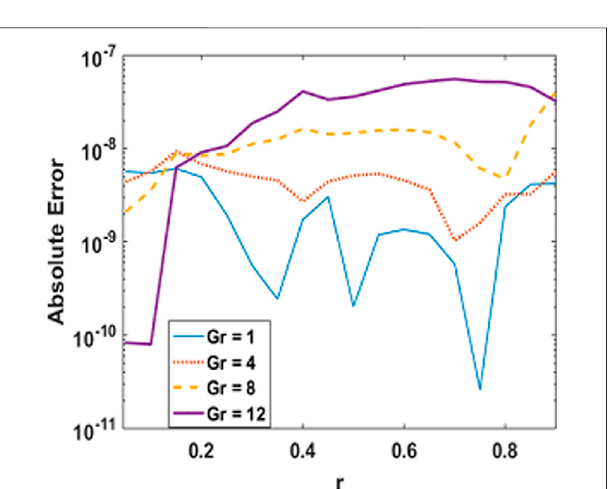
FIGURE 3 | Error in w(r) for magnetic parameter.